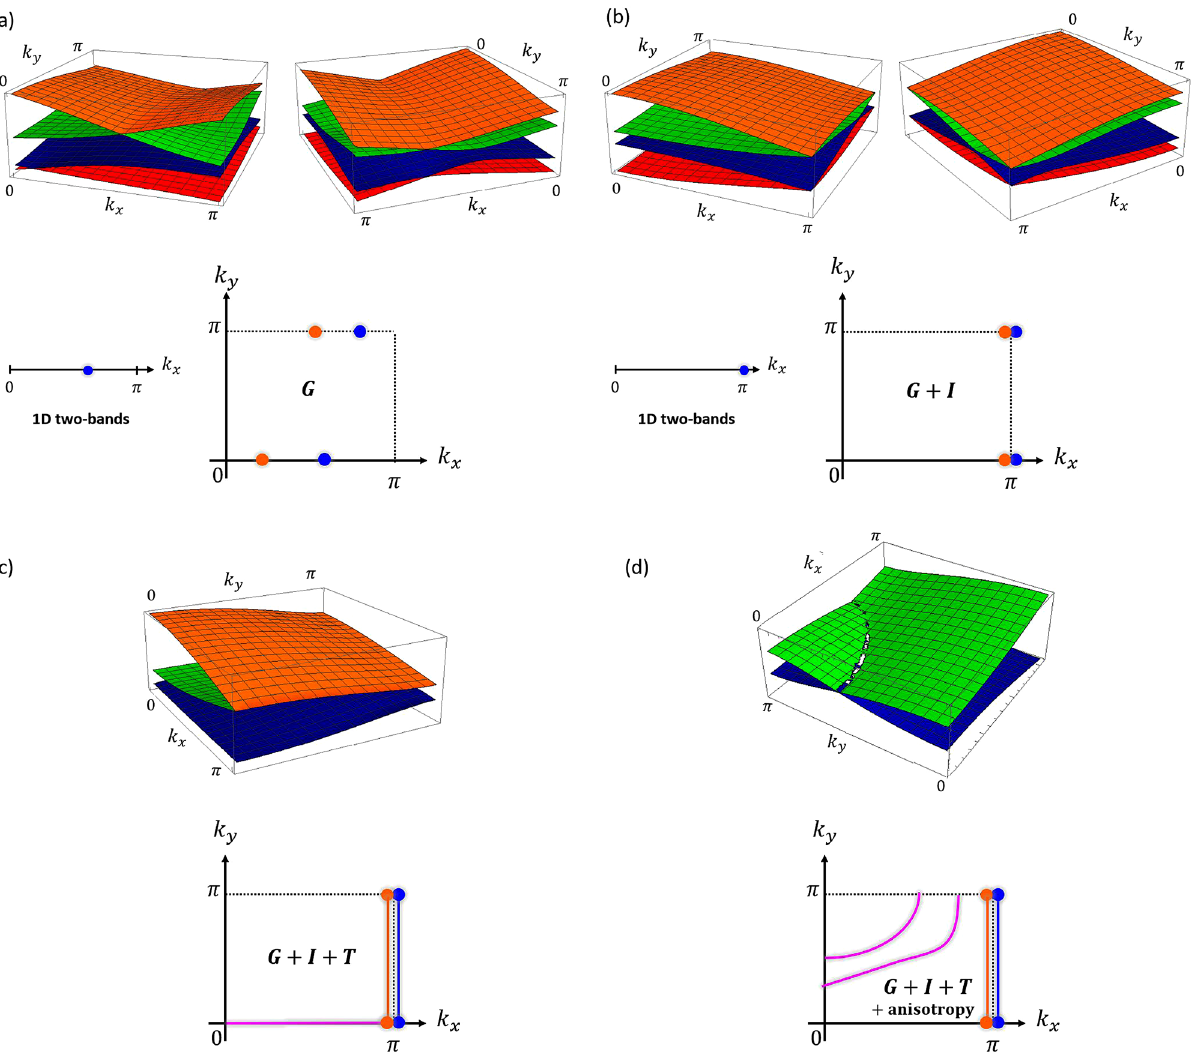
Figure 4. ( a–d ) Upper panels: Energy bands of the effective model with glide-plane (G) symmetry, with glide-plane (G) + inversion-point (I) symmetries, with glide-plane (G) + inversion-point (I) + time-reversal (T) symmetries, and with glide-plane (G) + inversion-point (I) + time-reversal (T) symmetries + anisotropy, k y plane of the nodal points or nodal lines shown on respectively. ( a–d ) Lower panels: Projection on the k x − the corresponding upper panels. The lower panels of ( a,b ) contain also the 1D two-band result for comparison. The lower panel of ( d ) illustrates two accidental nodal lines inside the Brillouin zone, corresponding to different anisotropic